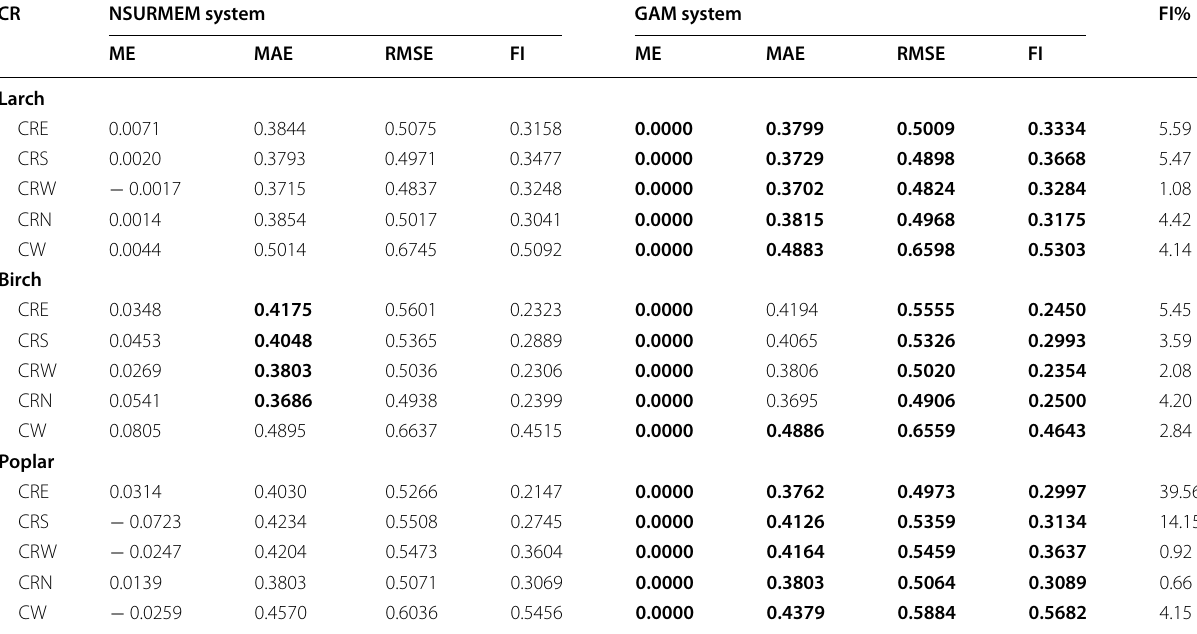
Note : The bolded numbers indicate the best performance for each case of the NSURMEM and GAM systems Table 9 The statistics of LOOCV of the NSURMEM and GAM systems for larch, birch, and poplar